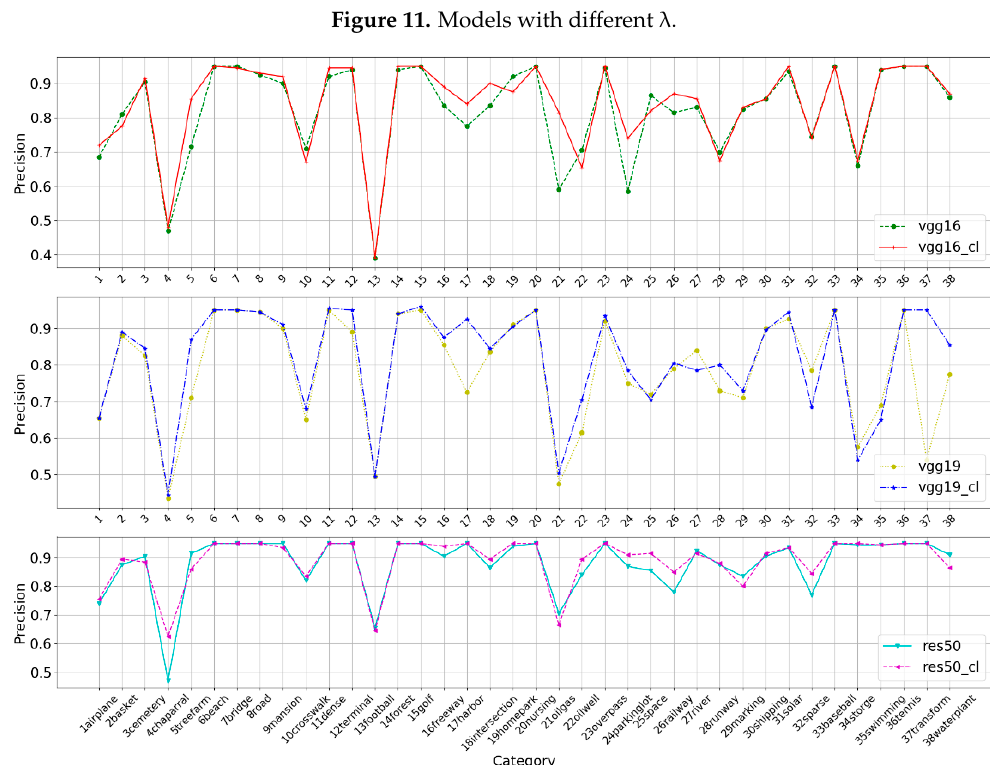
Figure 12. Class-level precision of different baselines trained under different loss function. vgg16_cl means the vgg16 trained under the joint supervision of the softmax loss function and the center loss function. Table 5. Comparisons of different CNNs (Convolutional Neural Networks) under different loss functions. CL means that the network is trained under the supervision of the softmax loss function and the center loss function. The best result for each baseline CNN is reported in bold. Description